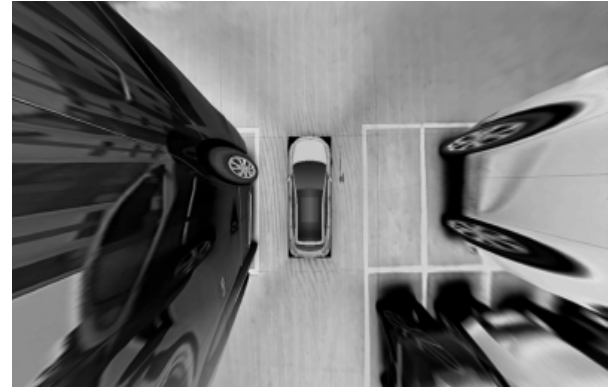
( f ) Figure 18. Test results. ( a ) Scene with fewer parking spaces. ( b ) Scene with lots of parking spaces. ( c ) Side parking scene. ( d ) Complex scene with ground marking lines. ( e ) Scene with complex lighting environment and lots of shadows. ( f ) Night scene. The image processing has been carried out on the detected parking space to further identify and locate the parking space. The results are shown in the following figures. Figure 19 is the image after grayscale and filtering. It indicates that the over-bright state has been well controlled. Additionally, the image noise has been significantly reduced. The parking space and other details have been well preserved. Since the processed image is still illuminated unevenly and the image contains a lot of interference information, such